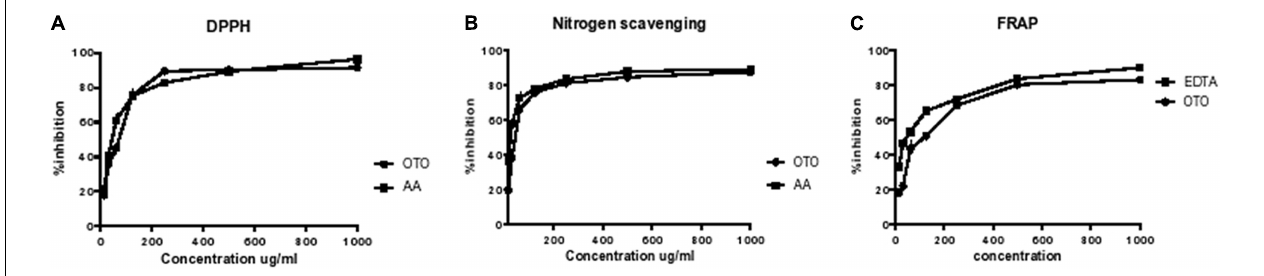
FIGURE 2 | Effect of O. limbata : in vitro antioxidant assays. (A) DPPH percent inhibition. (B) Percent inhibition by iron chelation. (C) Nitric oxide percent scavenging.